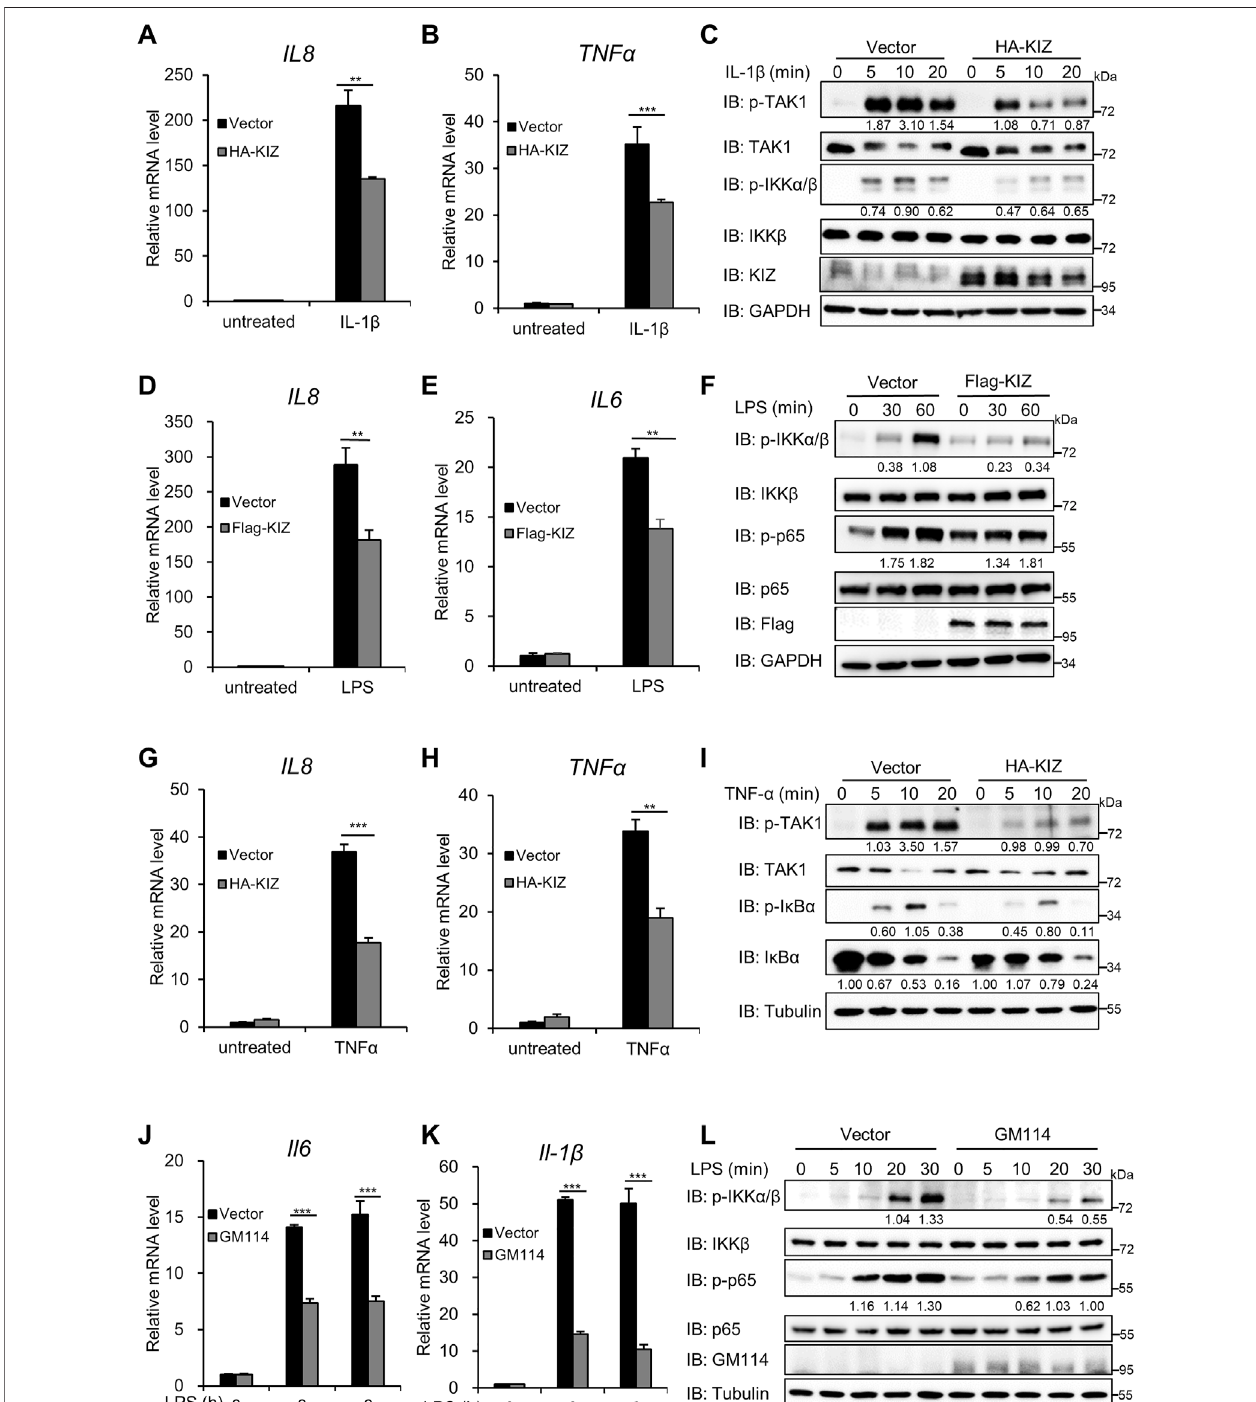
FIGURE1 | Overexpression ofKIZ/GM114 decreases IL-1 β /LPS/TNF α - induced NF- κ B activation. (A – C) HEK293C6cells were transfectedwith an empty vector or HA-taggedKIZ.After24 hoftransfection,the cellswere stimulated withhuman IL-1 β (5 ng/ml) for3 h and then analyzed by qPCRto measure themRNA levels of IL8 (A) and TNF α (B) or stimulated forthe indicated times and analyzed byimmunoblottingwith theindicatedantibodies (C) . (D – F) THP1 cellswereinfected withalentivirus that expressed anempty vectoror KIZ for48 h. The cellswerethen stimulated withLPS(1 μ g/ml)for3 h,followedbyqPCR tomeasure themRNA levels of IL8 (D) and IL6 (E) or stimulated for the indicated times, followed by immunoblotting (F) . (G – I) Similar to (A – C) , except the cells were stimulated with human TNF α (20 ng/ml). (J – L) RAW264.7cellswereinfectedwithalentivirusthatexpressedanemptyvectororGM114for48 h,stimulatedwithLPS(100 ng/ml)fortheindicatedtimes,andthen analyzedbyqPCR tomeasure themRNAlevelsof Il6 (J) and Il-1 β (K) orsubjectedtoimmunoblotting (L) .Datashown in (A,B,D,E,G,H,J,K) are fromone representative experiment of three independent experiments (mean ± SD, n = 3). ** p < 0.01; *** p < 0.001; two-tailed Student ’ s t-test.